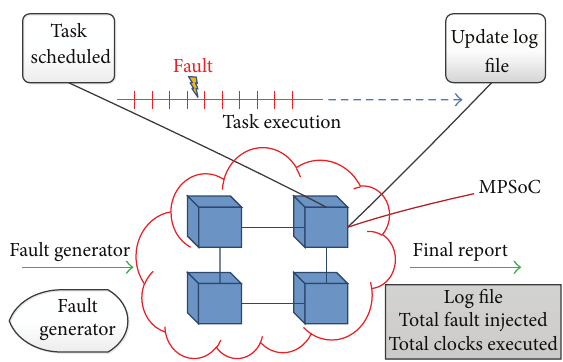
Figure 3: Experimental